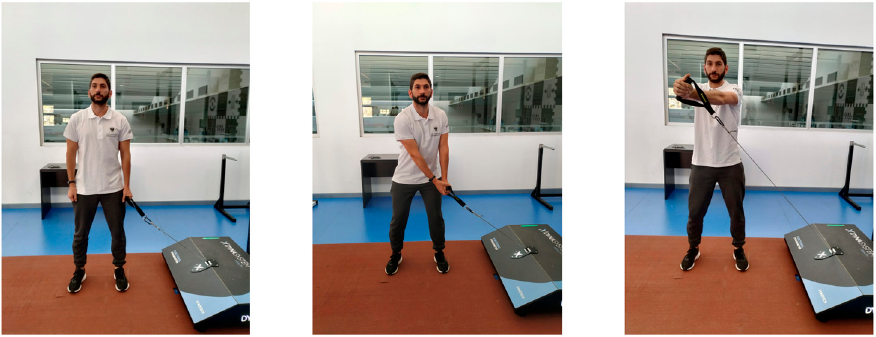
Figure 2. Assessment of low cable woodchop exercise using a functional electromechanical dyna- mometer.